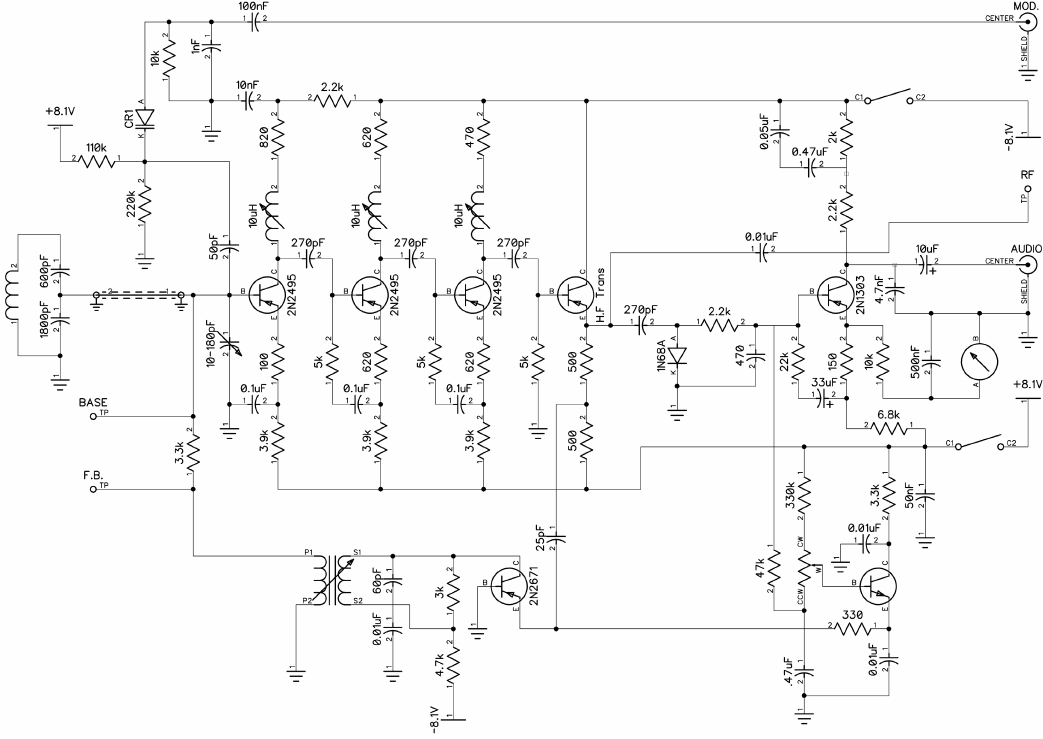
Figure 13 . A frequency sweep oscillator utilizing transistors. Figure 13. A frequency sweep oscillator utilizing